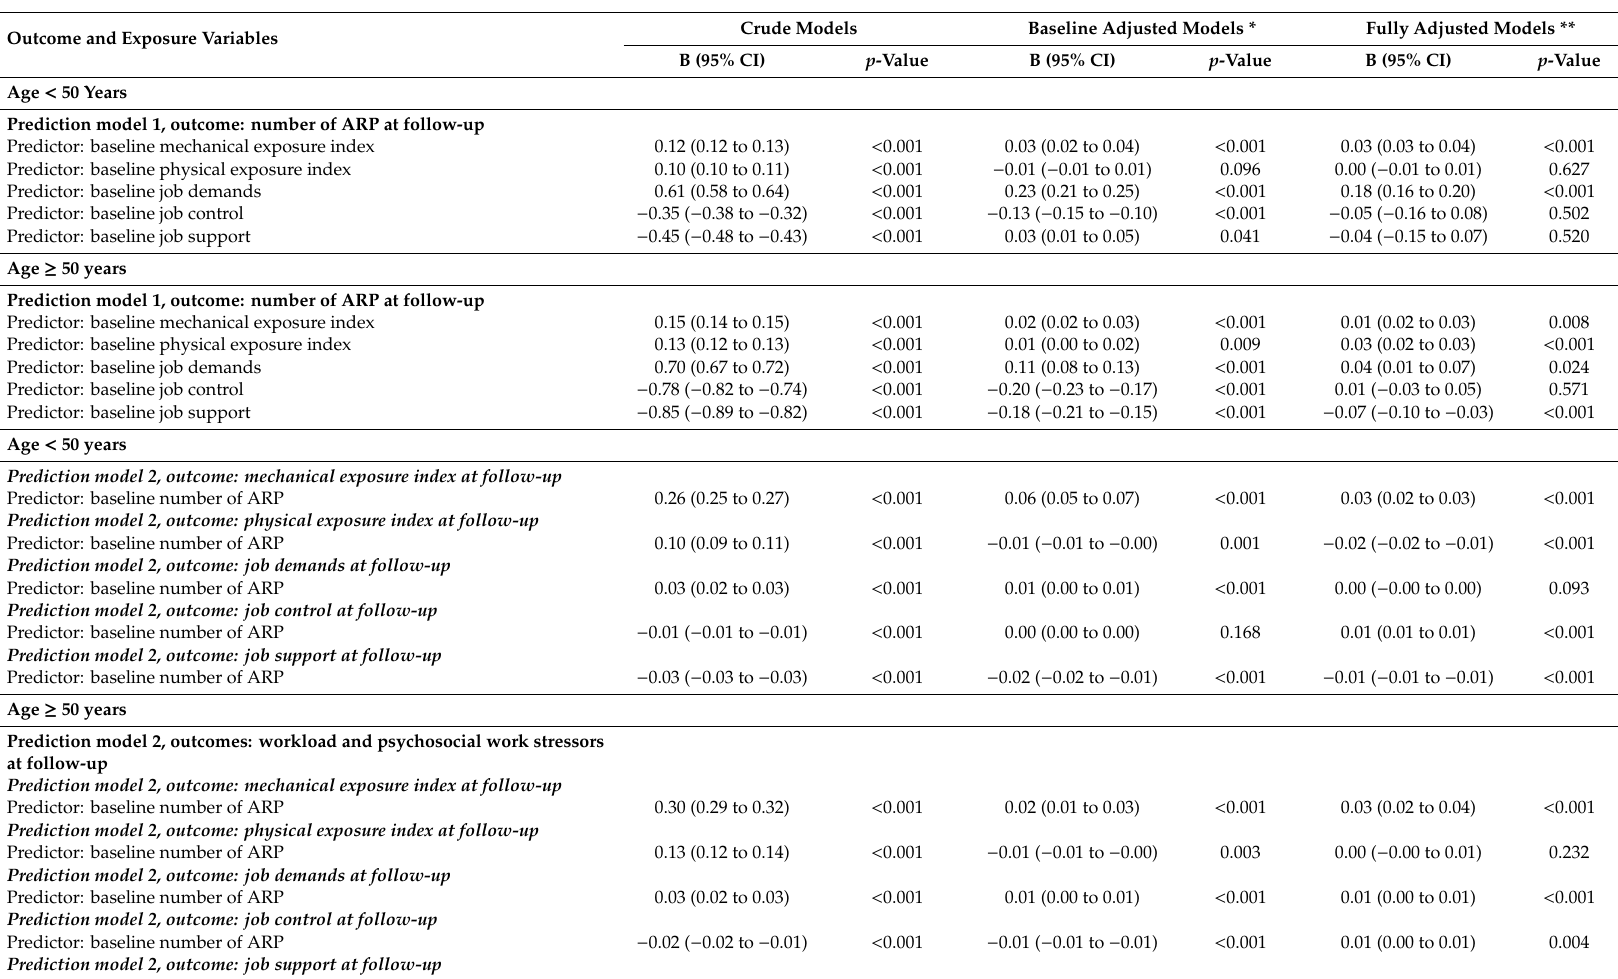
Table 4. Prediction models between workload, psychosocial work stressors, and the number of anatomical pain regions stratified by baseline age. Outcome and Exposure